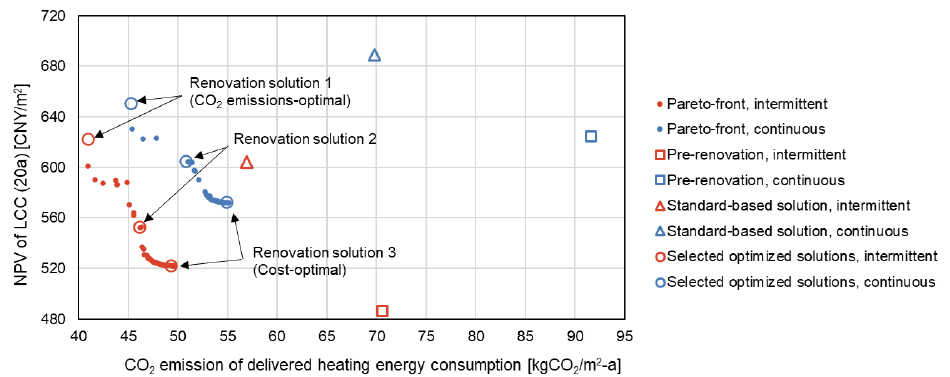
Figure 5. The annual CO 2 emissions and lifecycle cost for optimized and standard-based renovation solutions with different heating modes. Table 5. Comparison of pre-renovation cases and renovation solutions under intermittent heating mode.